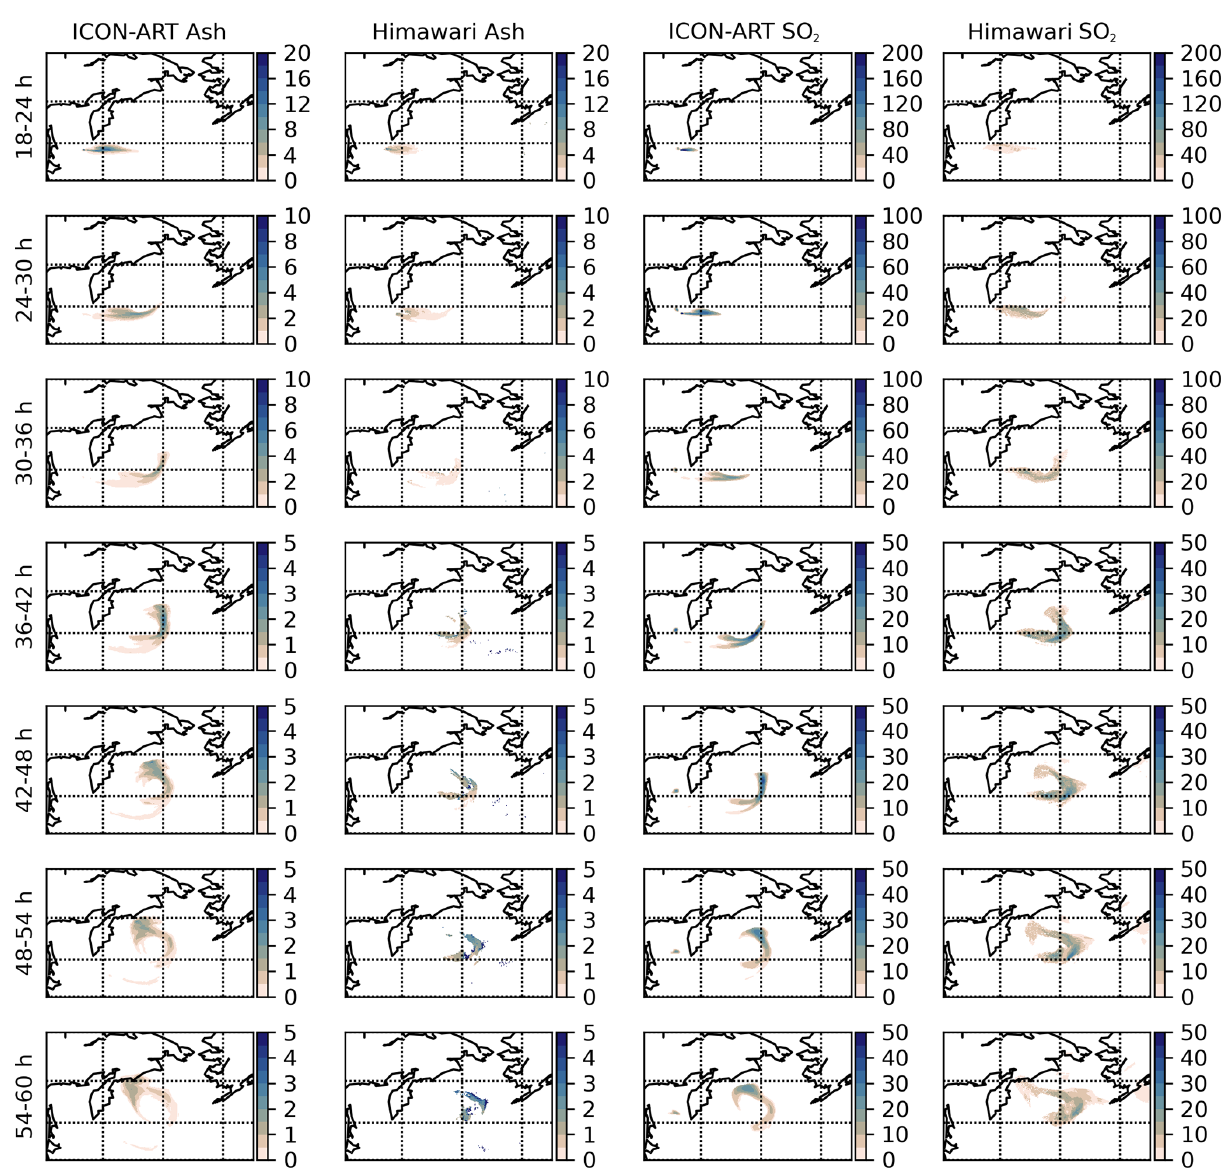
Figure A3. Comparison plots for seven ash and SO 2 6h averaged column loadings (row 1 to 7) in order to explain the discrepancy between simulated ICON-ART data and Himawari-8 observed data in the SAL analysis. First and second column: ash column loadings (gm − 2 ) from ICON-ART and Himawari-8. Third and fourth column: SO 2 column loadings (gm − 2 ) from ICON-ART and